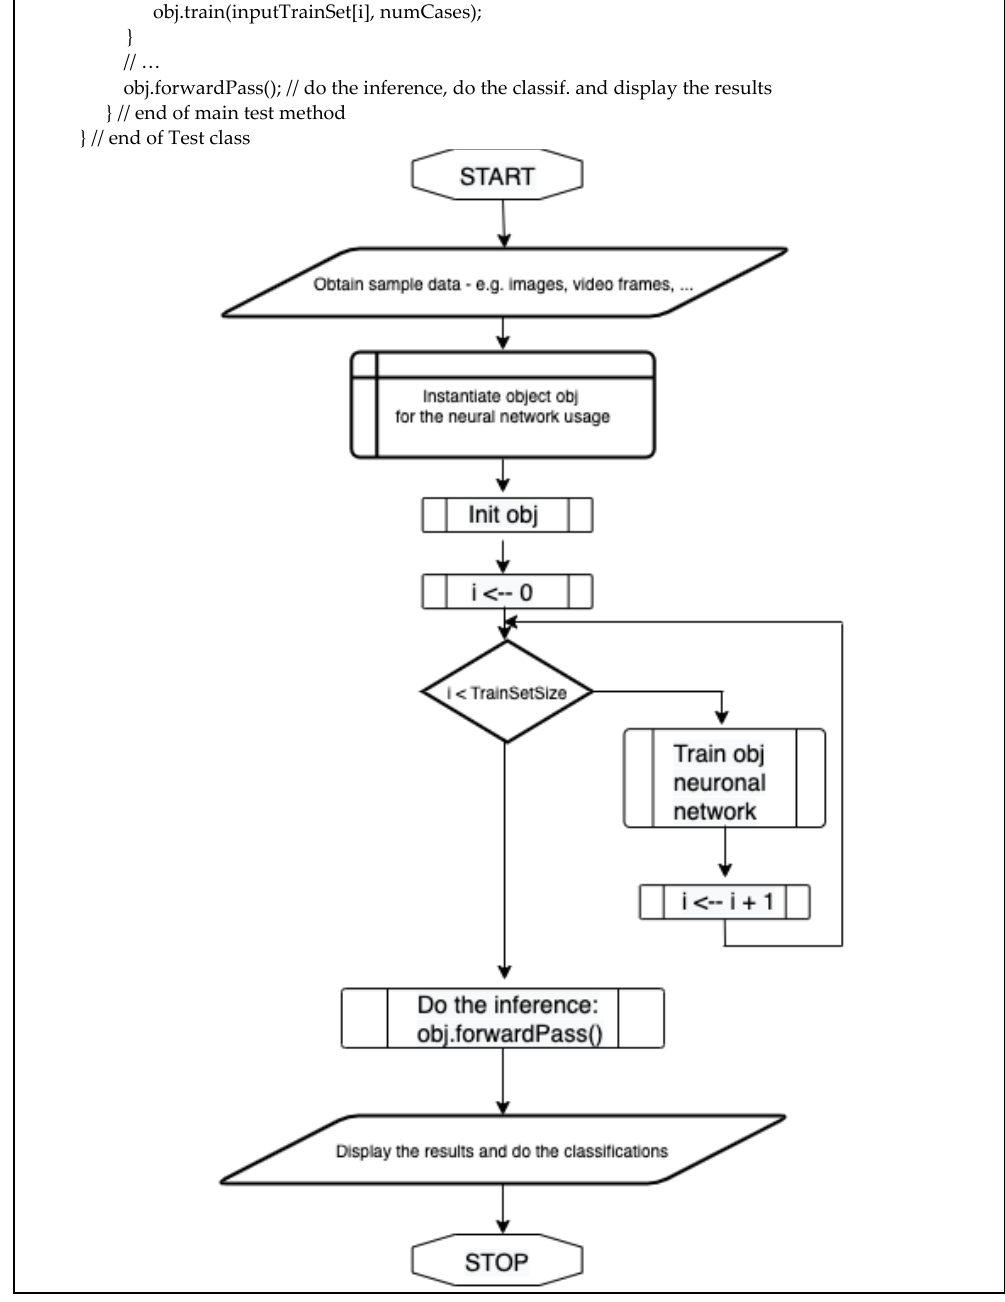
Figure 4. Java / Pseudo-Code for Neural Network Feed Forward with associated flowchart. Figure 4. Java/Pseudo-Code for Neural Network Feed Forward with associated